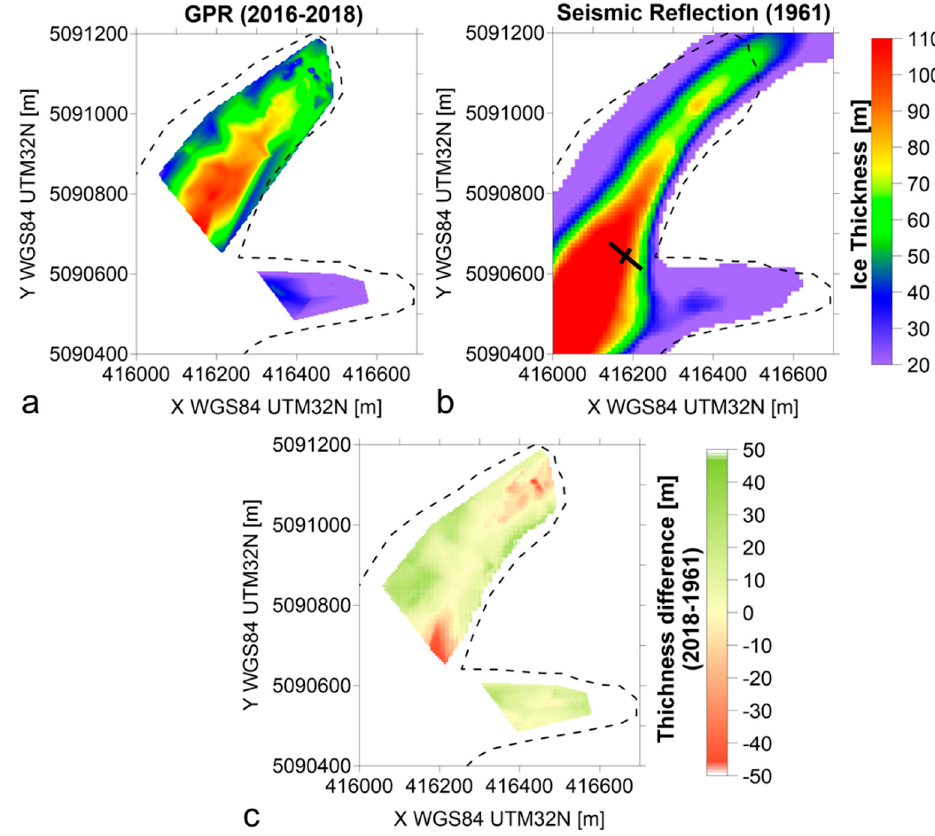
Figure 9. ( a ) Interpolated glacier bottom map from GPR results (2016–2018). ( b ) Reference glacier bottom map from De Visintini [35] and Diolaiuti et al. [39]. The black bold lines in ( b ) indicate the location of the only seismic reflection measurements in the area of interest. ( c ) Difference between ( a ) and ( b ) maps. The black dashed line highlights the approximate glacier perimeter in October 2016 (first GPR campaign).